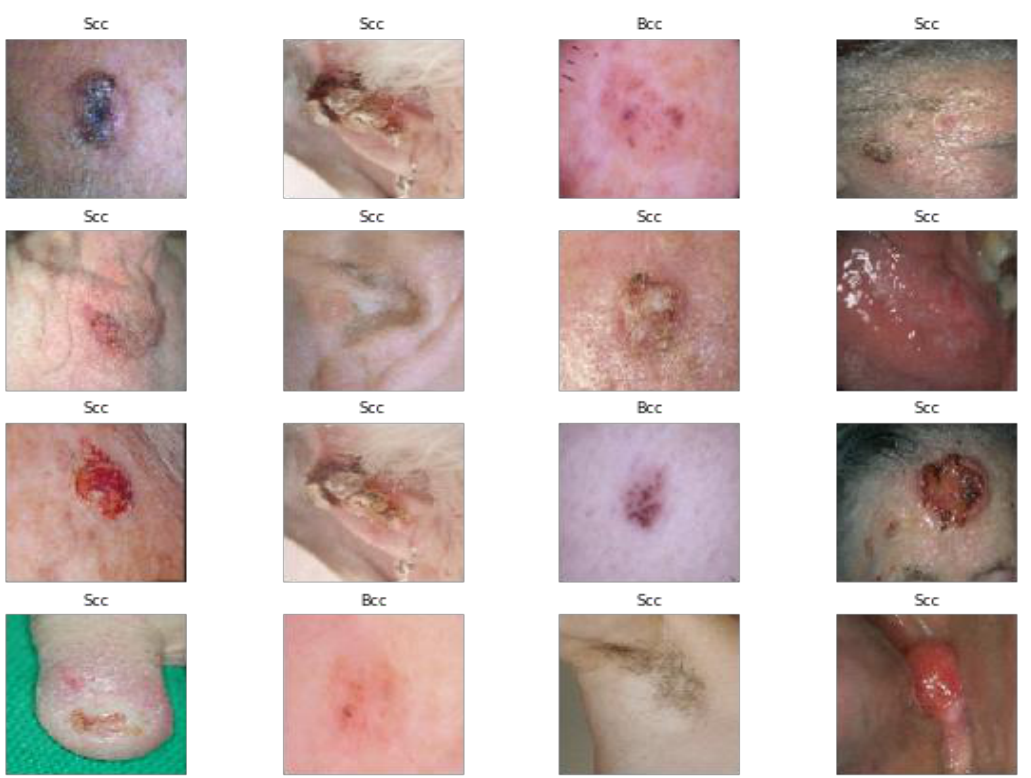
Figure 3. SMOTE Tomek generates samples of images to solve the class imbalance issue. Table 2. Image samples of skin cancer are distributed before